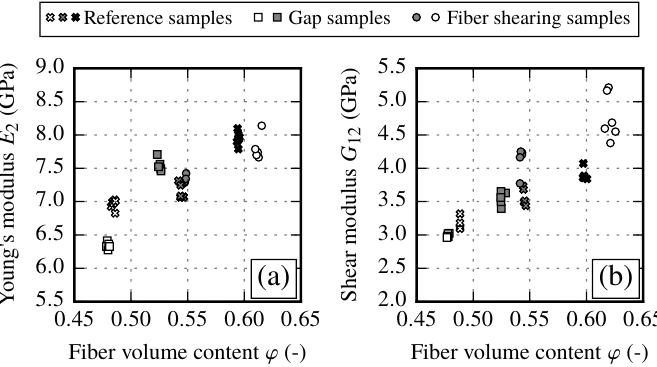
Figure 19. Comparison of the transverse modulus E 2 ( a ) and the in-plane shear modulus G 12 ( b ) for different draping effect